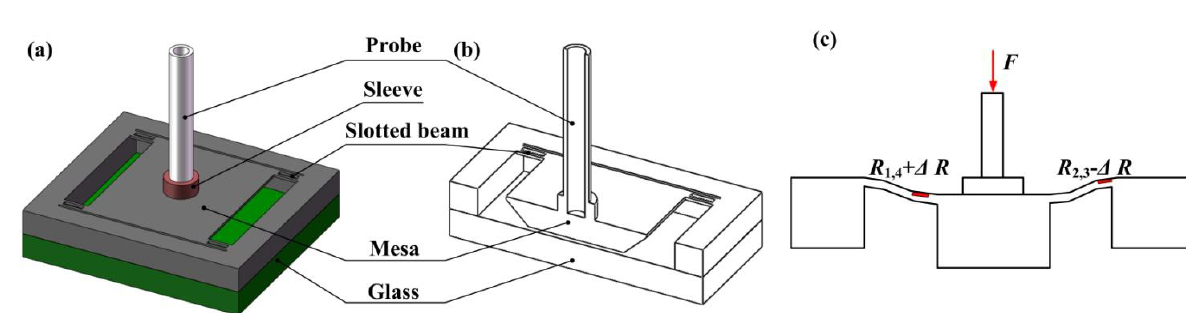
Figure 2. The SQB structure force sensor: ( a ) 3D view; ( b ) cross-sectional view; ( c ) deformation view of the structure under the applied force F